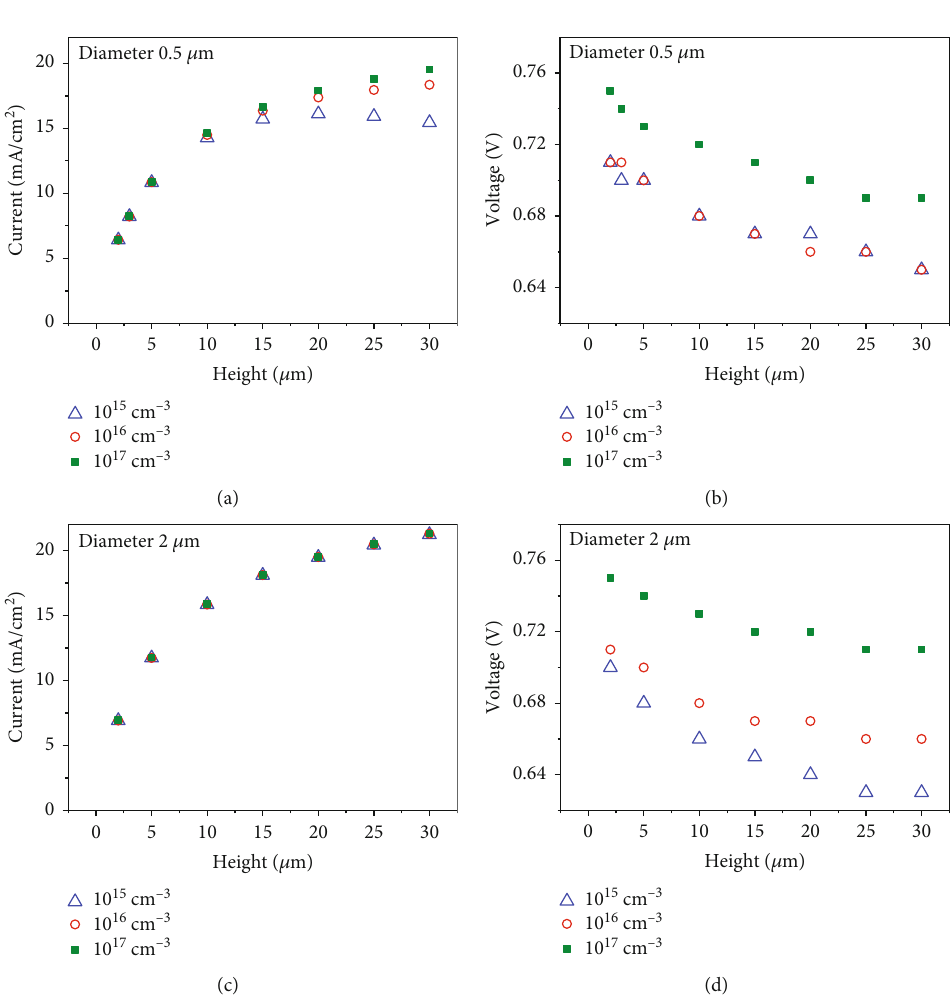
Figure 5: Calculated values of (a, c) J SC and (b, d) V OC for the bottom junction as a function of the height of silicon wires for a wire diameter of (a, b) 0.5 μ m and (c, d) 2 μ m and the MCC lifetime in (n) c-Si 10 μ s.